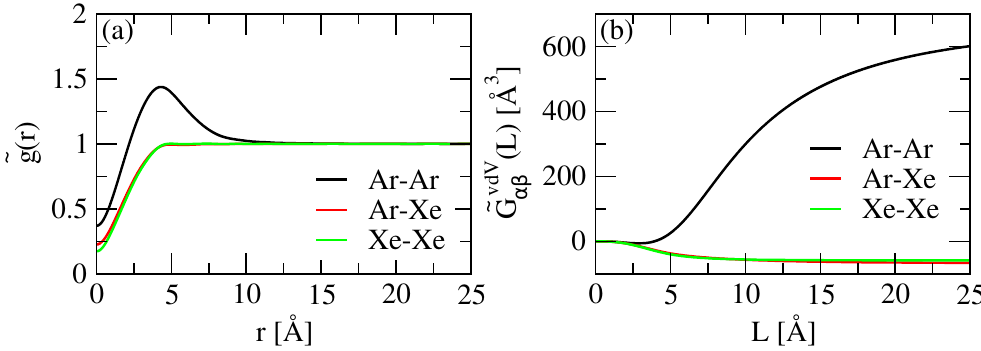
Figure 3. ( a ) RDFs convoluted by Equation (12) and corrected by Equation (15) at T = 85 K and x Ar = 0.02. ( b ) KBIs calculated by Equation (7) using ( a ).